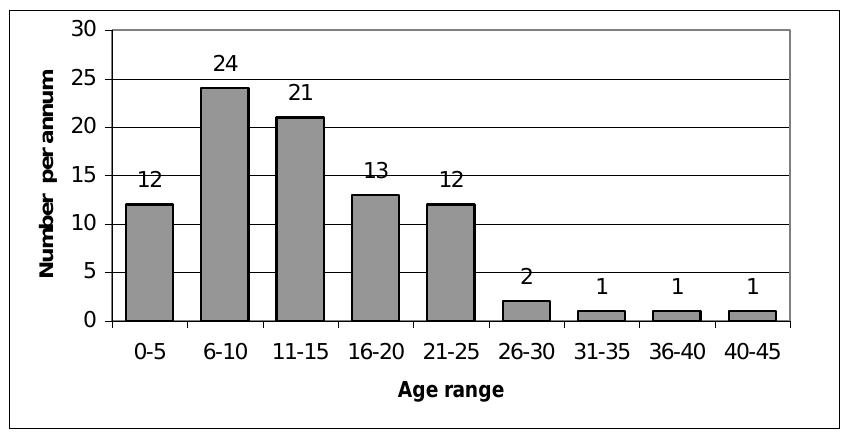
FIGURE 1. Prevalence of individuals diagnosed with RS in Israel, according to